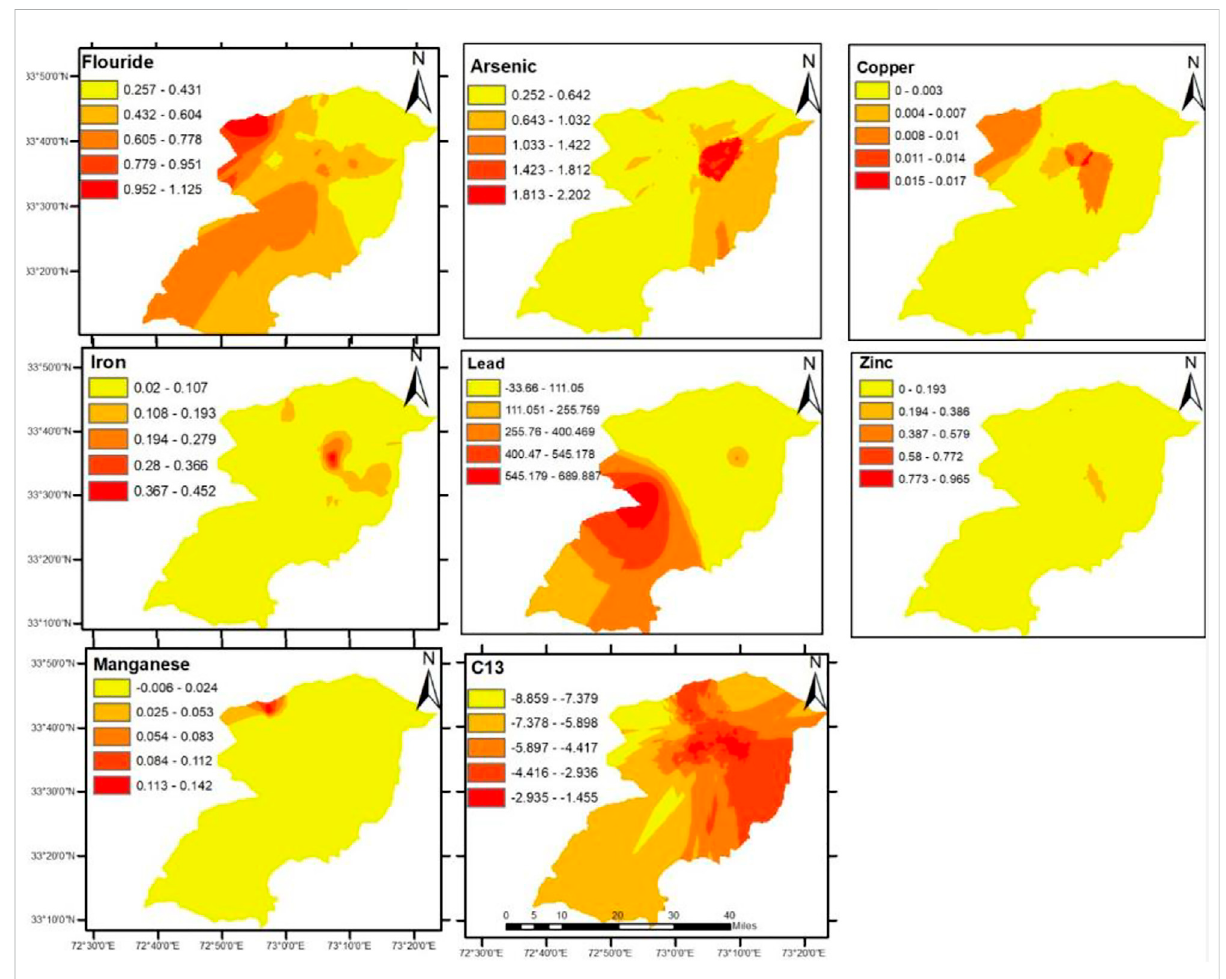
FIGURE 4 Spatial distribution of heavy metals and δ C13 in the groundwater of the “ twin cities ” of Rawalpindi and